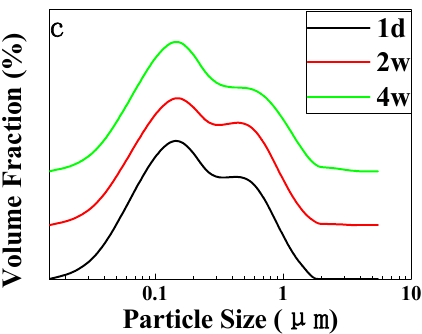
Figure 2. The distribution of di ff erent emulsion’s particle size over time: a : AES, b : APG, c : SDS.